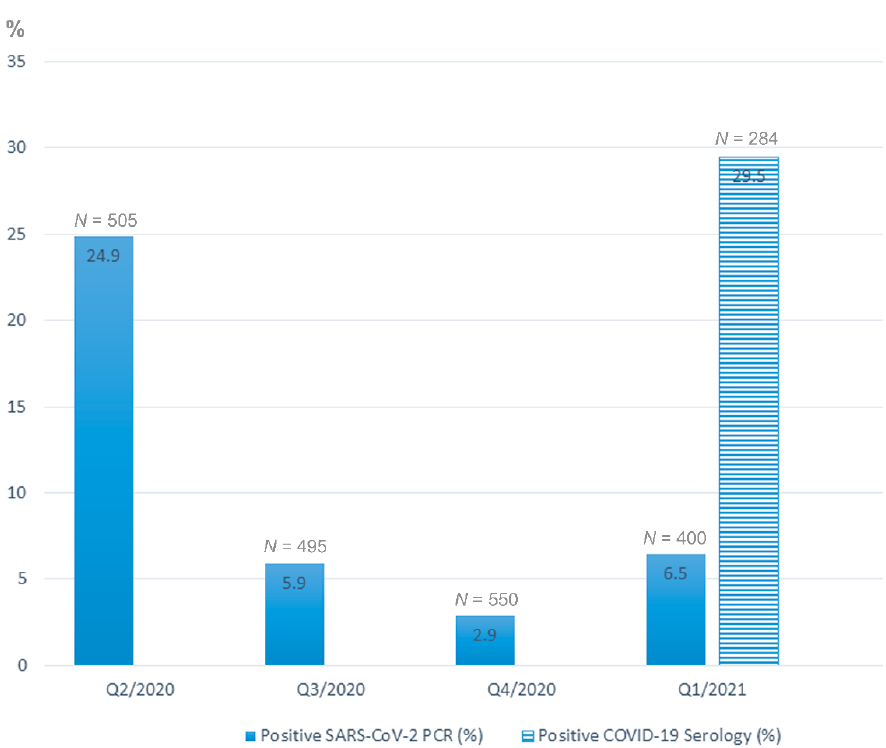
Figure 1. Dynamics of SARS-CoV-2 infection in parturient women in our medical center. The infection was detected by nasopharyngeal swab RT-PCR tests from the second quarter of 2020 (Q2/2020) to the first quarter of 2021 (Q1/2021). COVID-19 serology tests